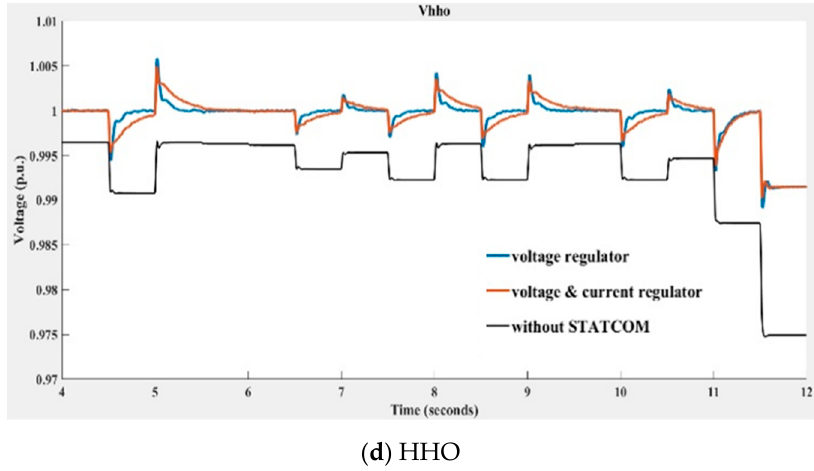
Figure 21. Voltage at the 33 kV bus with and without STATCOM compensation obtained using ( a ) PSO, ( b ) GWO, ( c ) KH, and ( d ) the HHO algorithms (blue line: swarm-based voltage regulator and classic current regulator; orange line: swarm-based voltage and current regulators; black line: without compensation).